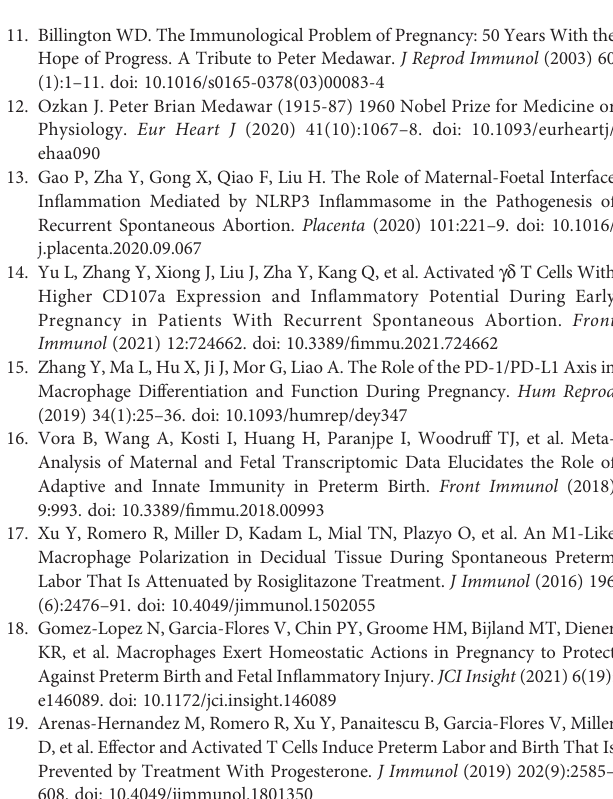
Supplementary Table 1 | Staining Panels for Flow Cytometric Analyses. Supplementary Figure 1 | FMO Controls of CD86, iNOS and CD206 in Flow Cytometric Analysis of Macrophages. (A) FMO Controls of CD86; (B) FMO Controls of iNOS; (C) FMO Controls of